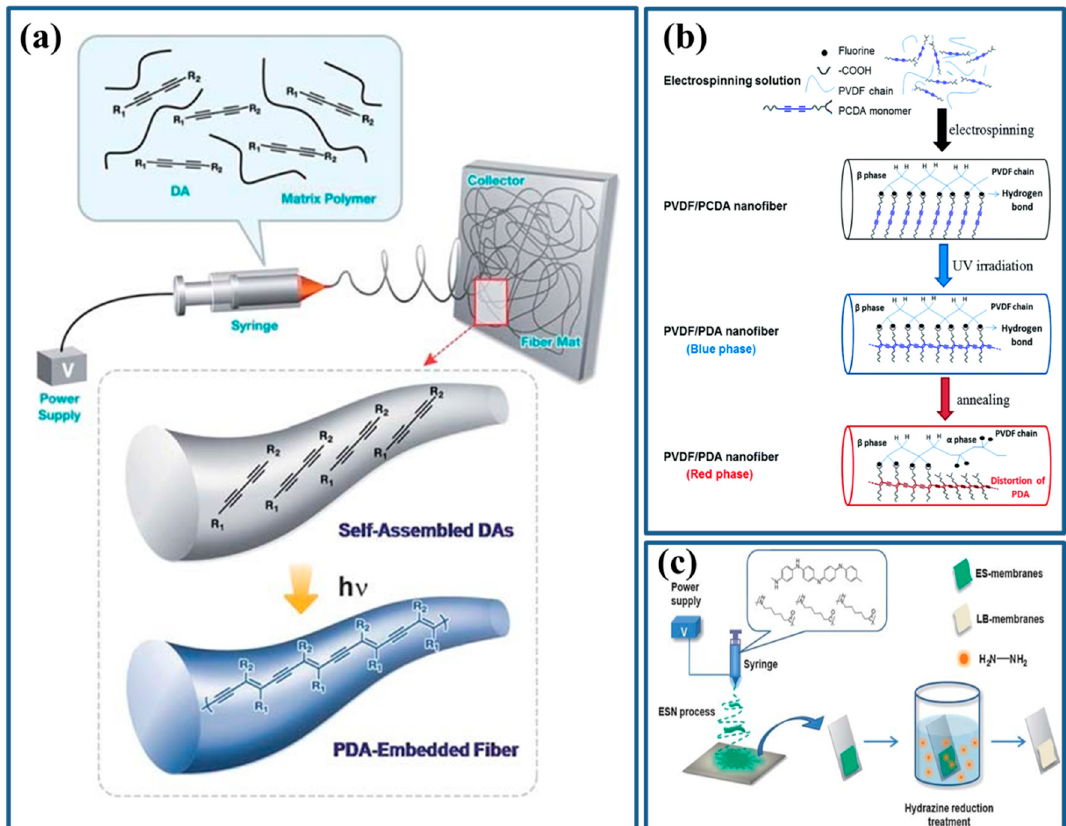
Figure 2. ( a ) Schematic representation of blended polydiacetylene (PDA) with carrier polymer electrospun onto the grounded collector under a high voltage. Reprinted from work in [74] with permission from Royal Society of Chemistry. ( b ) Demonstration of established electrospun nanofiber with hydrogen bonding b / w polyvinylidene fluoride (PVDF) and PDA. Adapted from in [75] with permission from Royal Society of Chemistry and ( c ) polyaniline (PANI) blended onto polyamide (PA)-6 matrices producing the colorimetric sensory fibers. Adapted from work in [76] with permission from Royal Society of Chemistry.